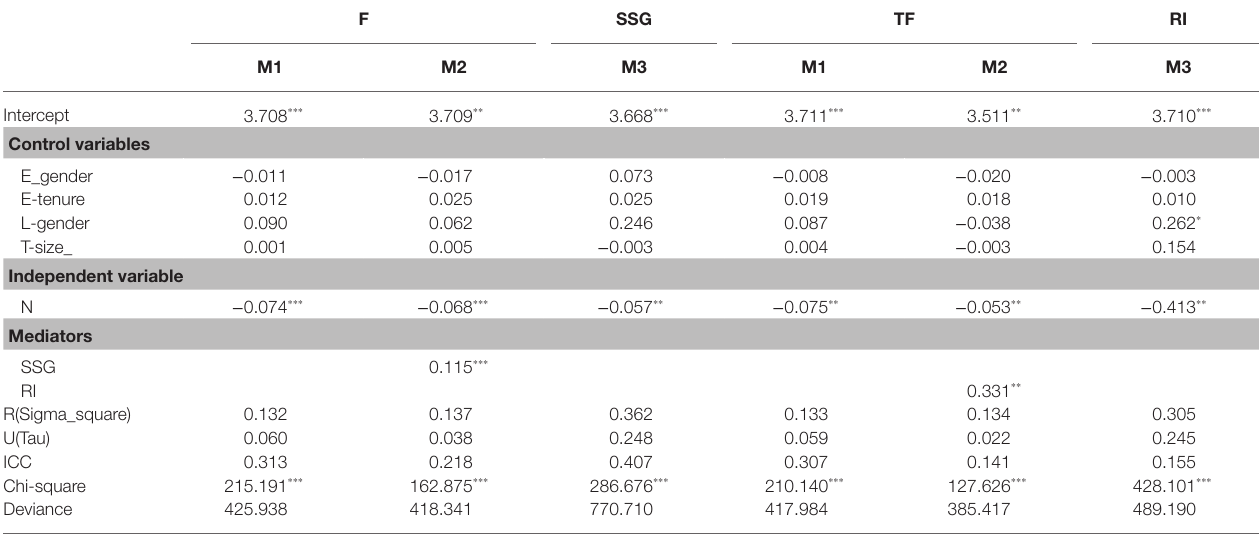
TABLE 5 | Results of mediating regression tests. F SSG TF RI M1 M2 M3 M1 M2 M3